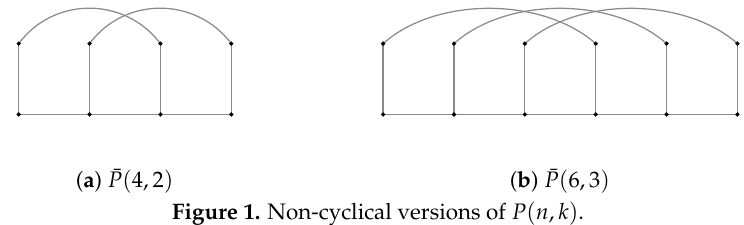
Figure 1. Non-cyclical versions of P ( n , k ) .